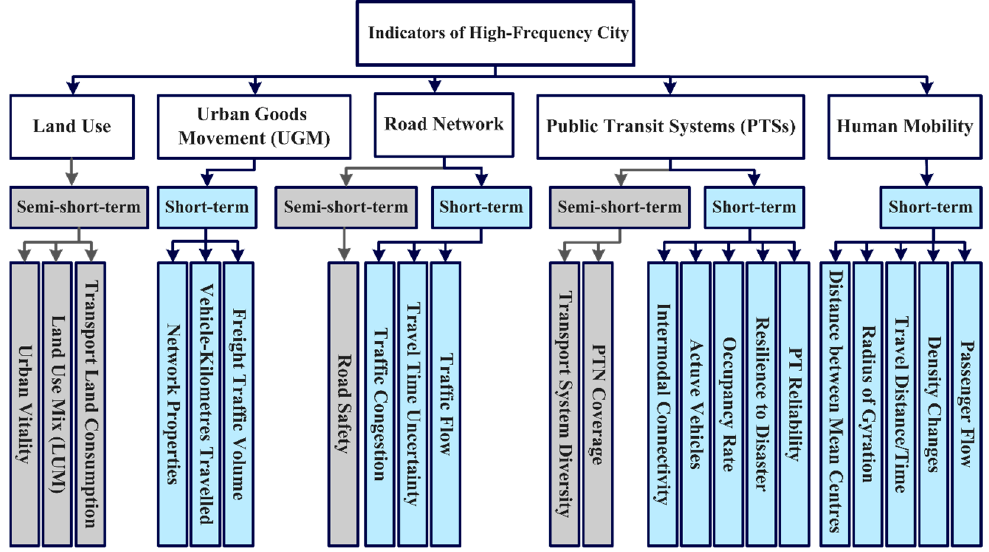
Figure 6. Proposed indicators of high-frequency cities.